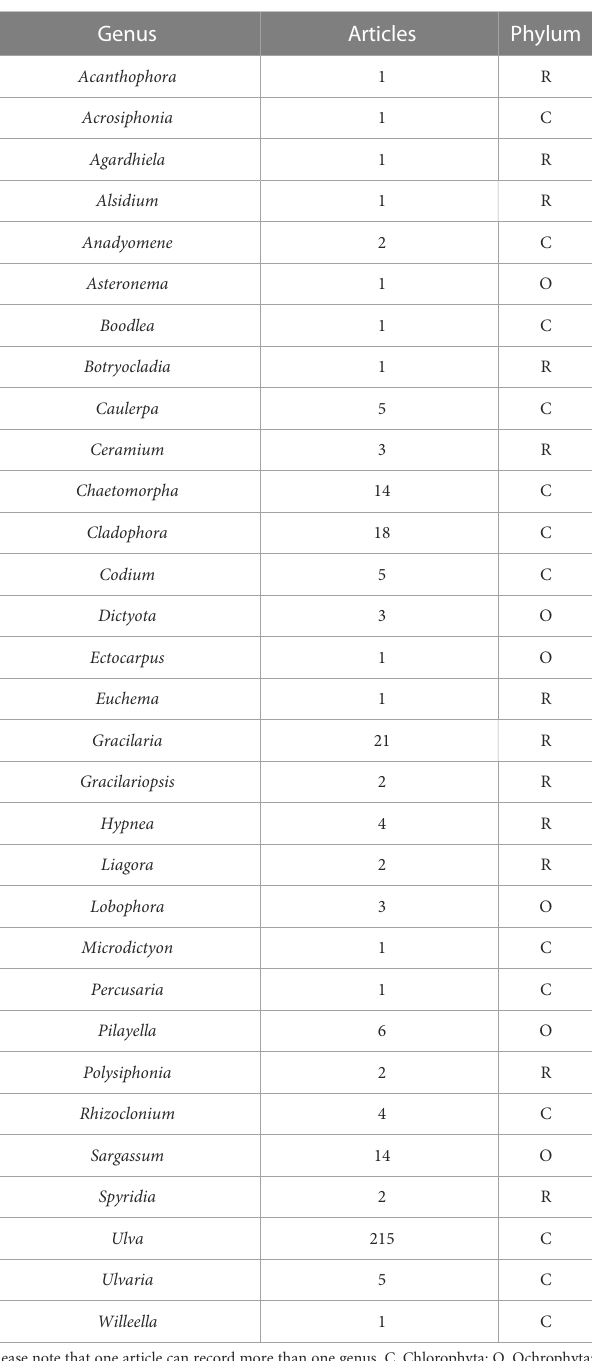
TABLE 1 Genera of bloom forming macroalgae recorded in the 265 original articles